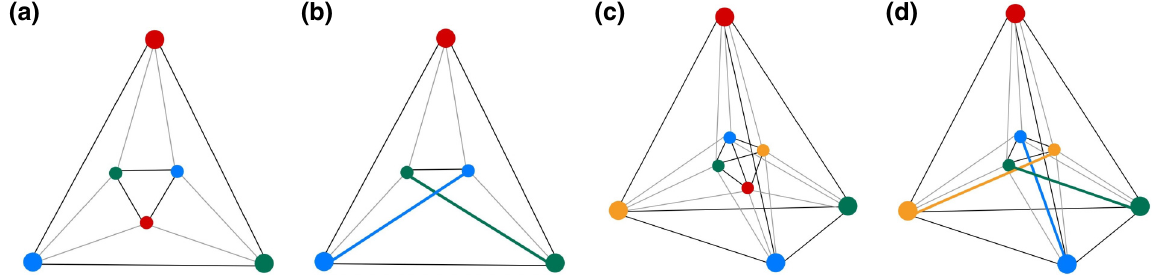
FIG. 12. QRM codes and their morphed counterparts. (a) QRM ( 2 ) , more commonly known as the Steane code. Qubits are on triangles and stabilizer generators are associated with internal vertices. (b) The [[5,1,2]] code produced by morphing the colorable 2-ball centered at the internal r vertex. Four qubits are replaced by two (the blue and green edges). (c) QRM ( 3 ) , more commonly known as 15-qubit Reed-Muller code. Qubits are on tetrahedra and X -type ( Z -type) stabilizer generators are associated with internal vertices (edges). (d) The [[10,1,2]] code produced by morphing the colorable 3-ball at the internal r vertex. Eight qubits are replaced by three (the blue, green, and yellow